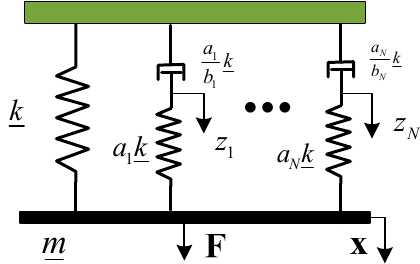
Figure 2. Mechanical analogy of the Biot model.